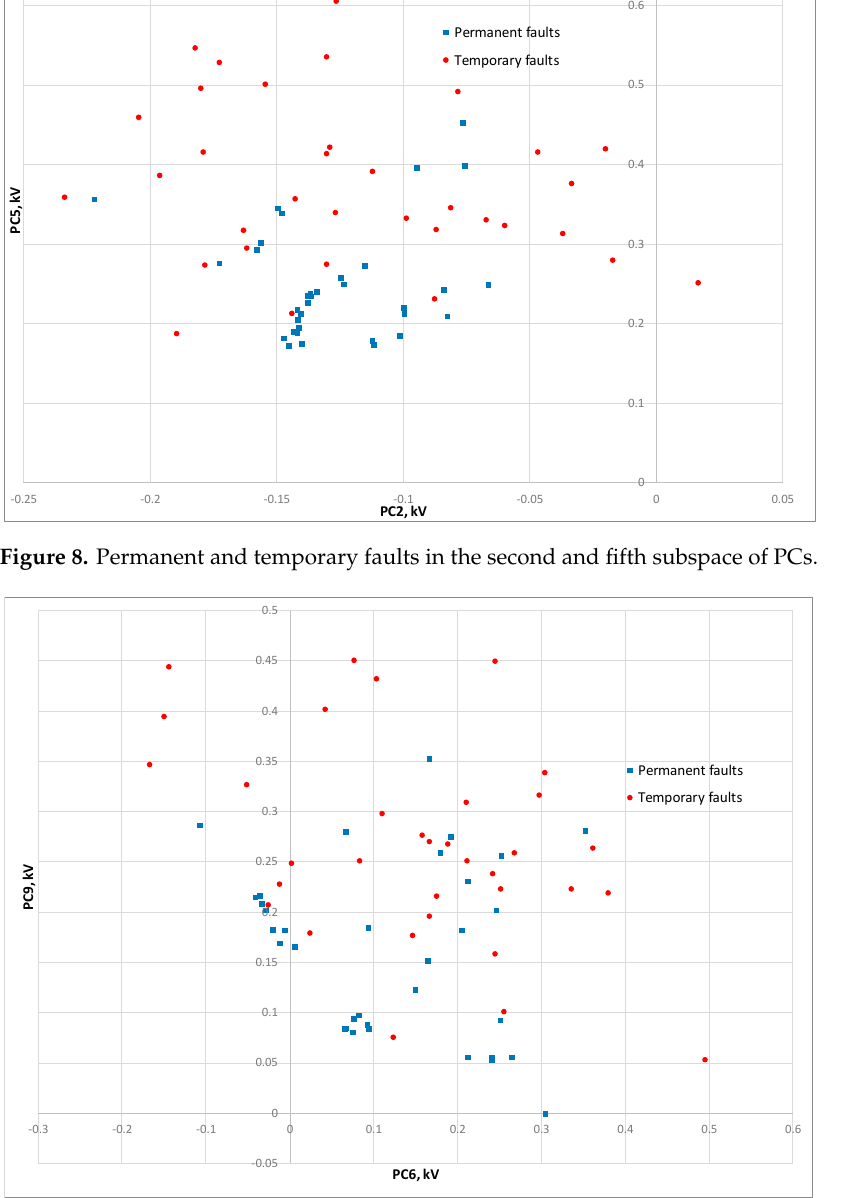
Figure 9. Permanent and temporary faults in the sixth and ninth subspace of PCs.